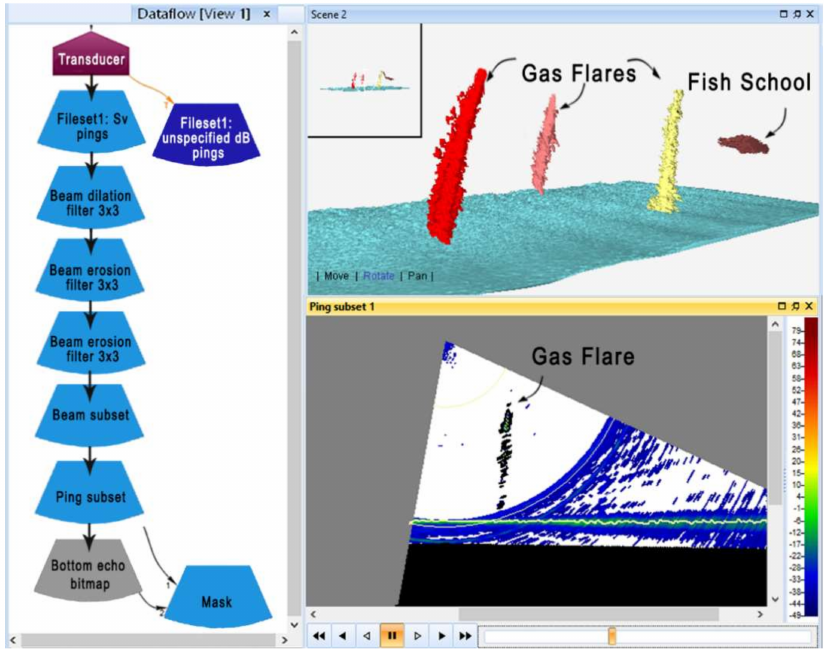
Figure 4. Standard Echoview ® Dataflow Window showing the operators used for automatically filtering the data ( left ); the 3D scene window with the cluster regions detected in the ping subset ( upper right ); the ping subset window of the filtered multibeam echogram displaying a gas flare in the water column ( lower right ).